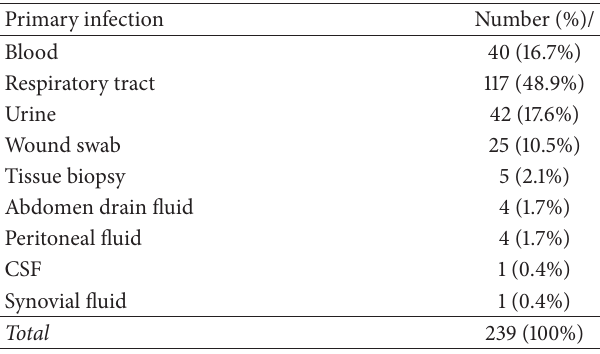
Table 3: Sites of infection.